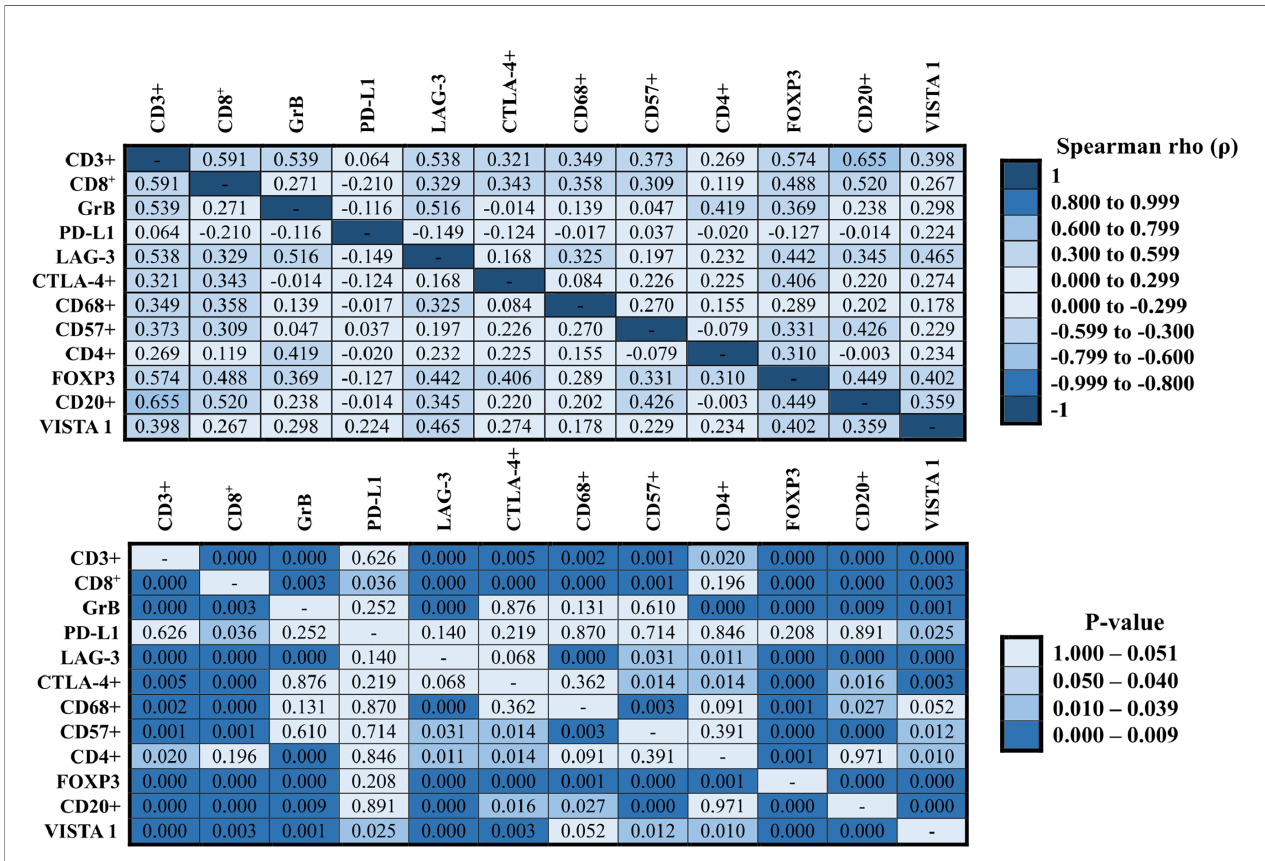
FIGURE 4 | Correlation between immune proteins expressed in NCLSC. The heat-maps presented the correlation values. The superior heat-map presents the results for Spearman ’ s rho, and the bottom heat-map presents the equivalent P-values (Spearman ’ s